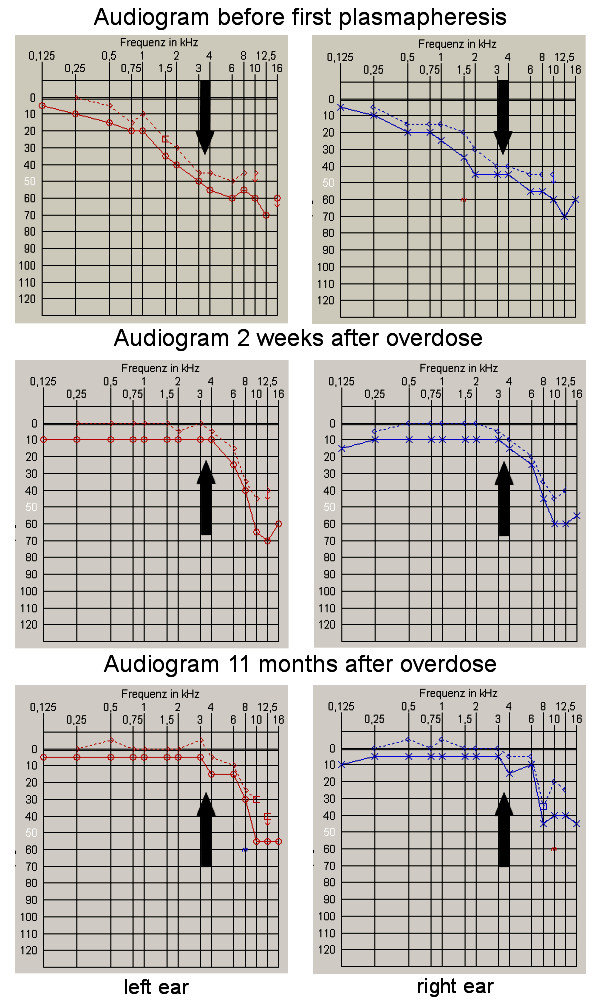
demonstrates the complete restitution of the hearing curves from 0.75 kilohertz to 6 kilohertz in the audiograms of the patient performed at three different times. On the x-axis the frequency in kilohertz is shown, the y-axis indicates the loudness in decibel. The arrows point at the changes in the curves.